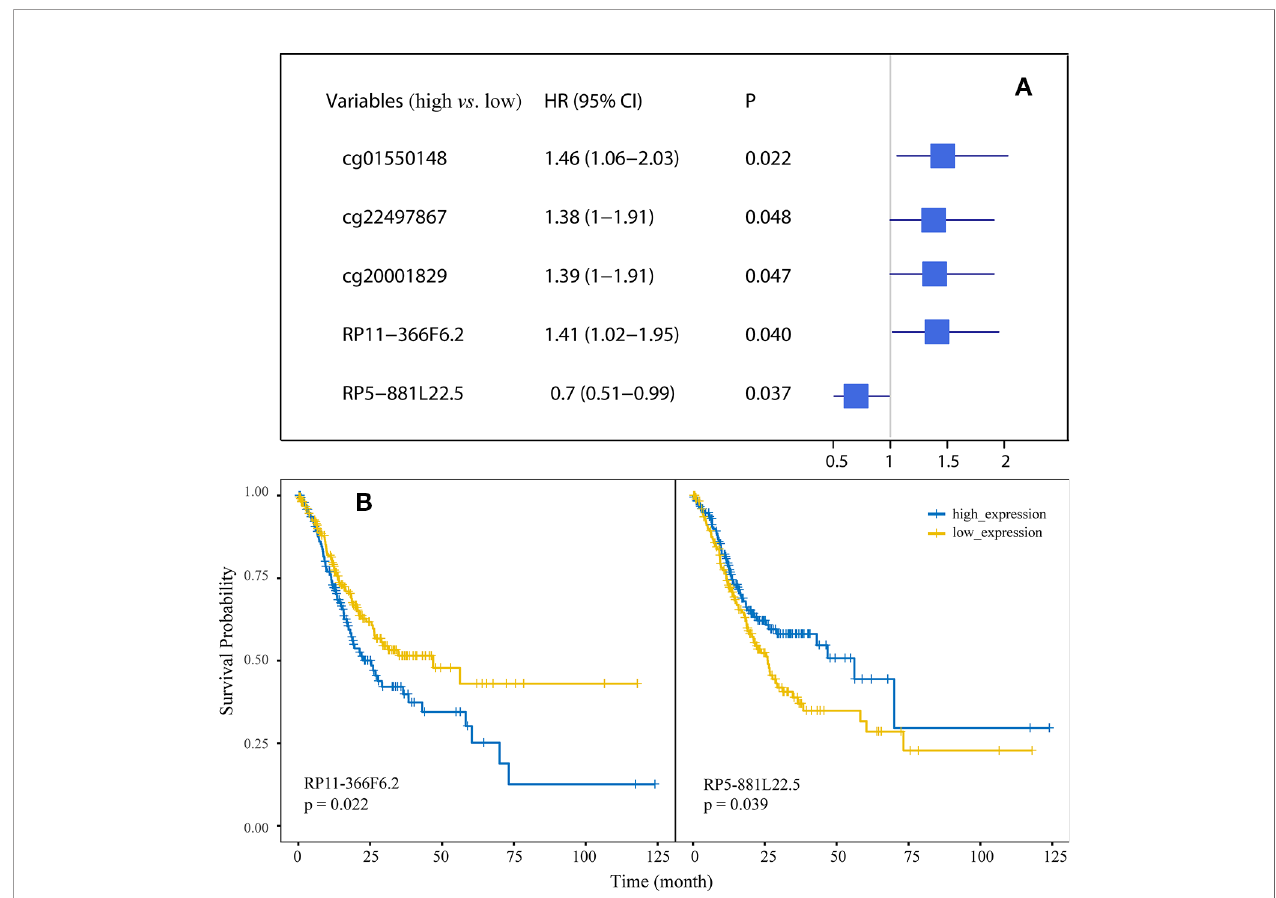
FIGURE 4 | Association of the methylation of differentially methylated CpGs (DMCs) and expression of differentially expressed long noncoding RNAs (DElncs) with survival of GC patients. (A) Forest plot depicting correlations between the methylation of DMCs with the survival of GC patients, using the median expression of probes as the cut-off value. (B) Kaplan-Meier analysis of overall survival for GC patients according to RP11-366F6.2 and RP5-881L22.5